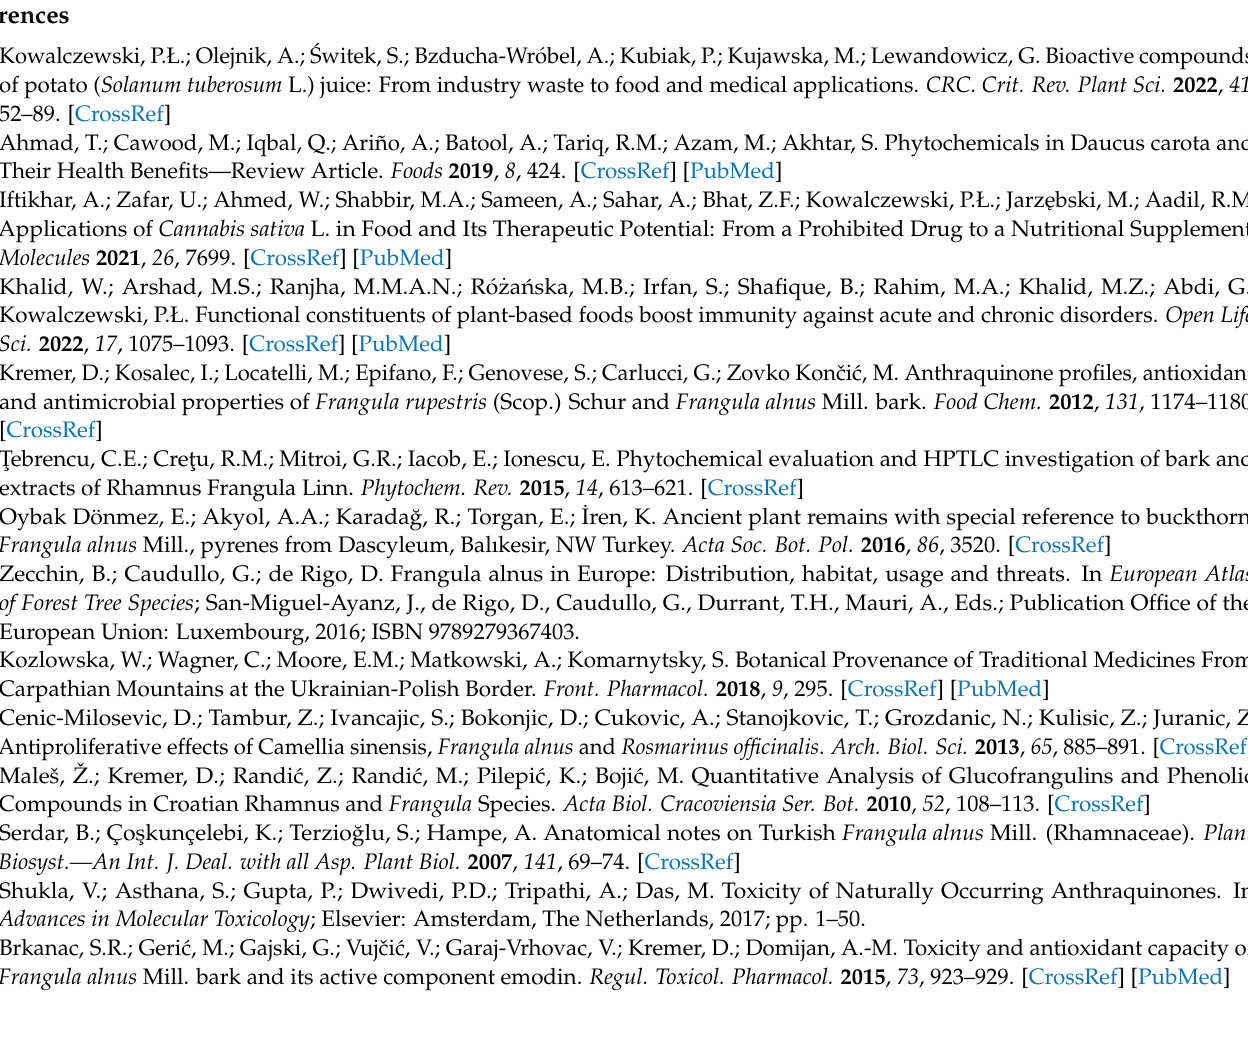
Table S3. GC-TOFMS analysis—examples of other compounds present in plant extracts after derivati- zation with BSTFA. References [36–45] are cited in the supplementary